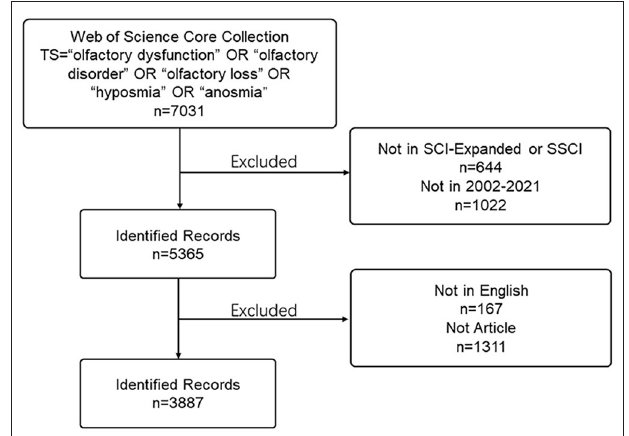
FIGURE 1 | Flow diagram of the literature